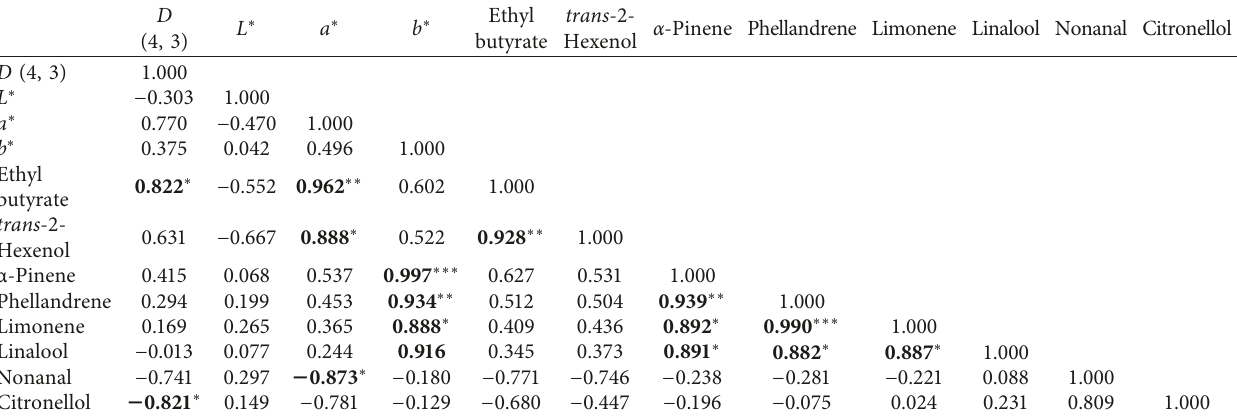
Table 2: Correlation coefficient matrix of 12 parameters measured in DPCD-treated orange juice